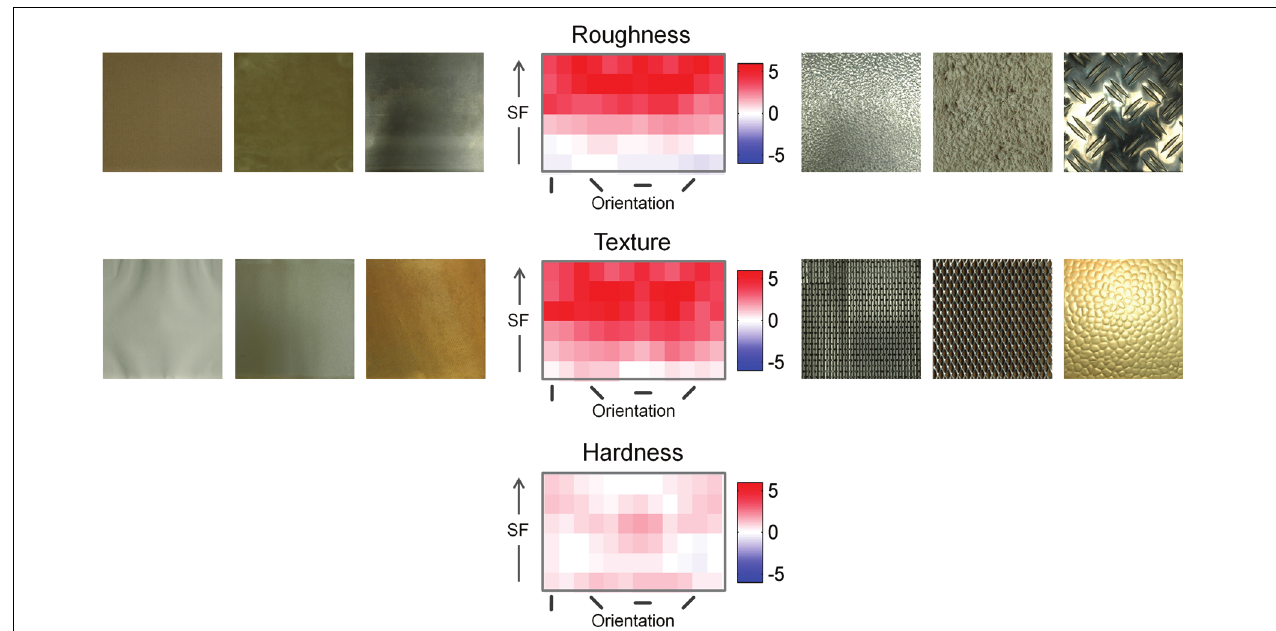
FIGURE 5 | Comparisons of steerable pyramid subbands between images with high and low ratings. The steerable pyramid is a bank of multi-scale, multi-orientation band-pass filters, spanning roughly one octave in bandwidth at each scale. Spatial frequency increases from bottom to top. Spatial frequency increases from bottom to top, ranging approximately from 0.07 to 4.6 cpd in logarithmic steps. Orientation represents the orientation of components in the Fourier spectrum. Positive t -values mean that the high-rating images have more energy in that subband. Left and right of the graph are example images that were correctly classified into the low- and high-rating groups, respectively. As examples we chose those images with the highest probabilities of belonging to their respective group as estimated by the classifier. Since the classifier performed at chance for images with high and low hardness rating, no material images are depicted here.